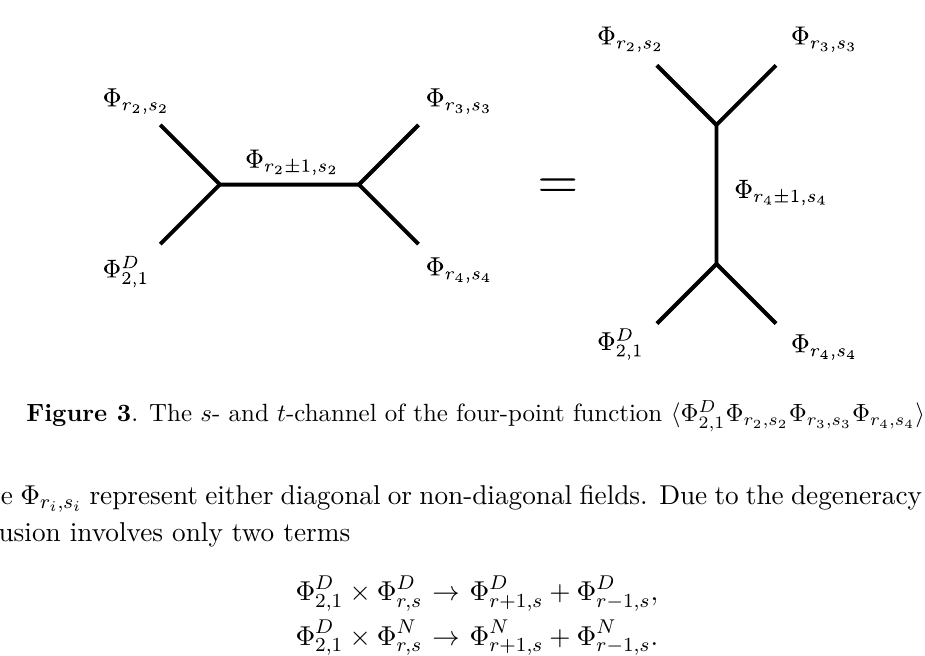
Figure 3 . The s - and t -channel of the four-point function h Φ D